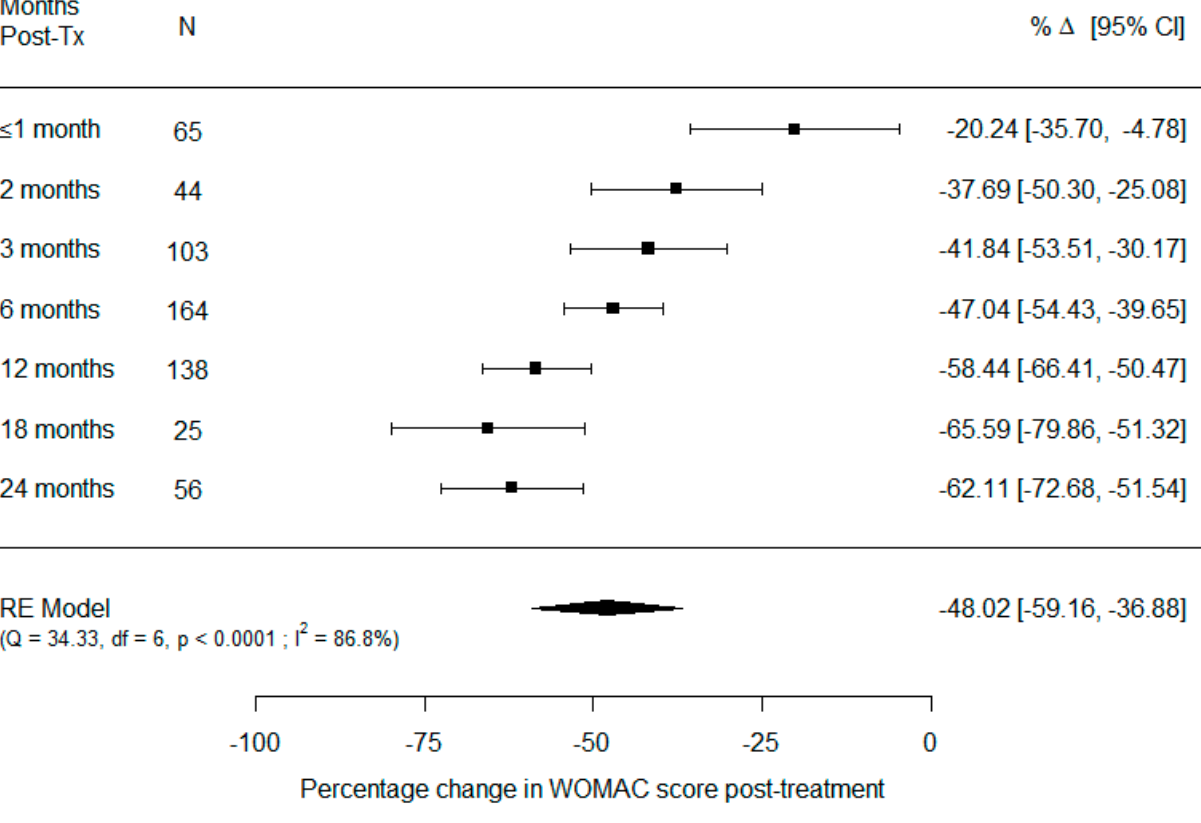
Figure 3. Forest plot showing pooled analyses of percentage changes in WOMAC scores across the different follow-up times (CI = confidence intervals, df = degrees of freedom, N = number, RE = random effects, Tx = treatment group).